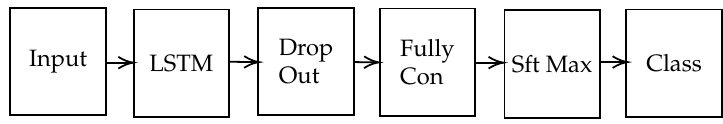
Figure 5. LSTM architecture block diagram.